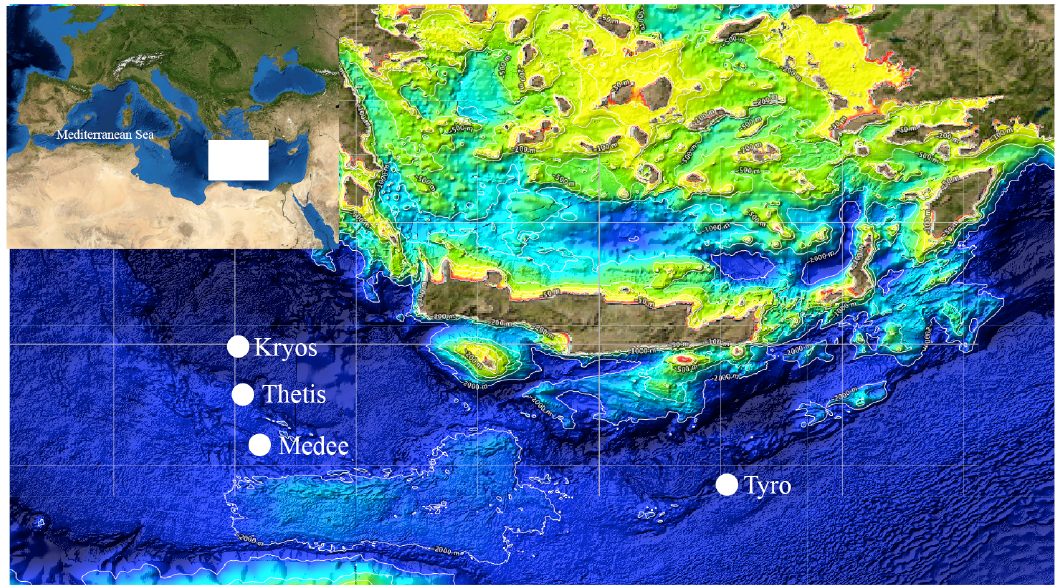
Fig. 1. Location of sampling sites. Data derived from the EMODnet (Marine Observation and Data Network) hydrography portal – http: Figure 1 – Location of sampling sites. Data have been derived from the EMODnet (Marine 602 Observation and Data Network) Hydrography portal - http://www.emodnet-hydrography.eu. 603